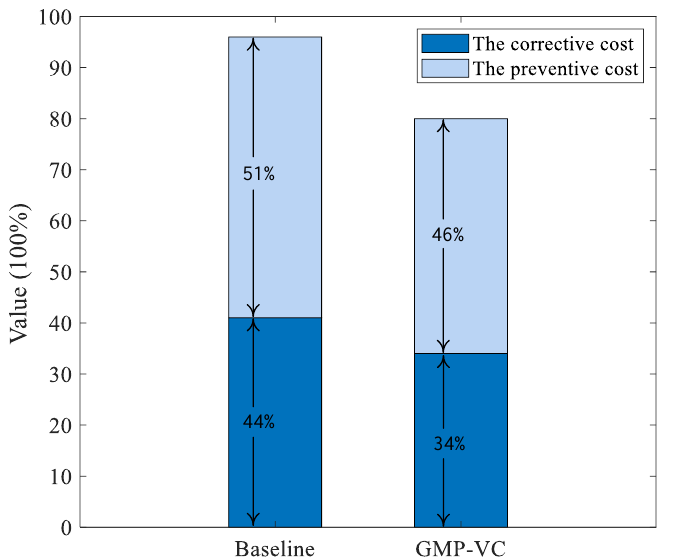
Figure 10. The maintenance cost comparison between the baseline plan and the GMP-VC.